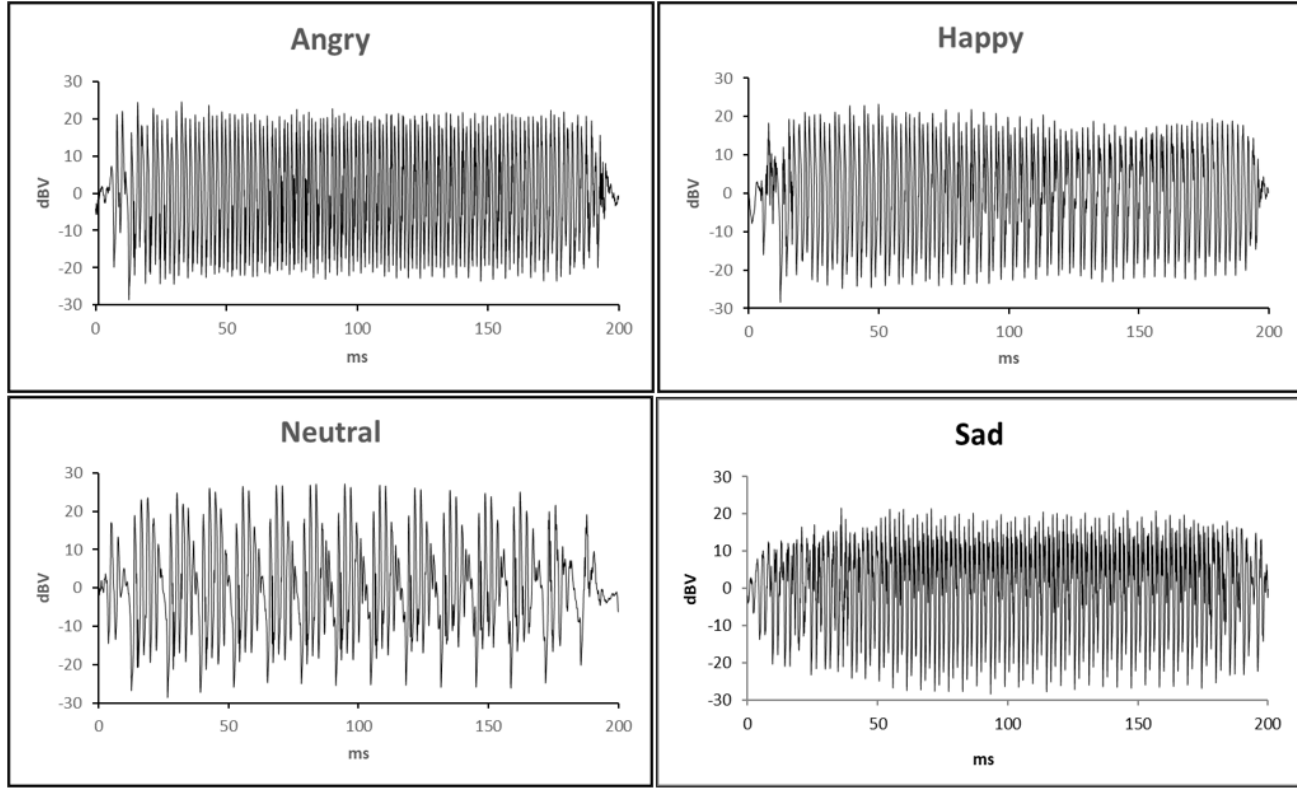
Figure 1. Electrical time waveforms (Adobe Audition CS6) depicting the monosyllabic stimulus/ba/stimulus presented in four emotions. dBV represents relative sound intensity in decibel-voltages, plotted against time in milliseconds (ms).